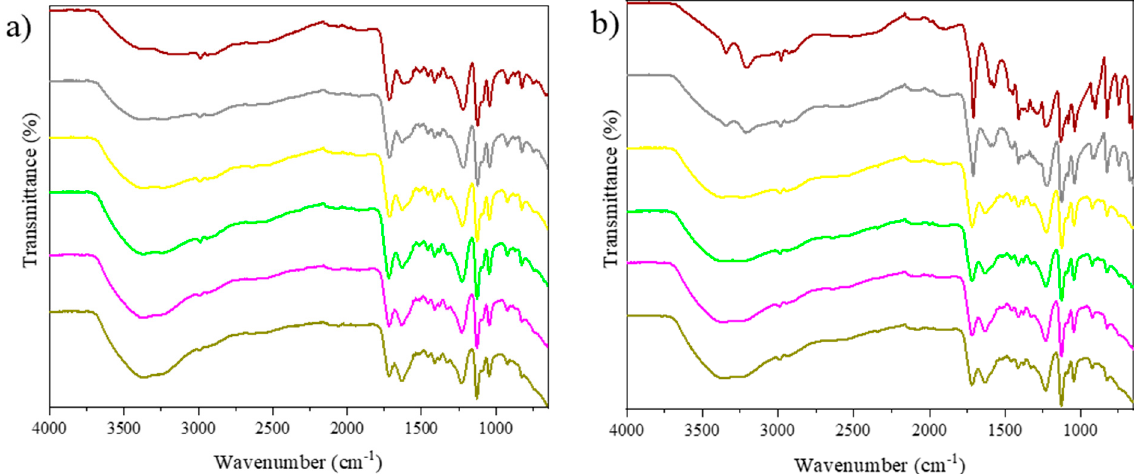
Figure 5. Spectra (FTIR) of lactic acid:glycine mixtures with different proportions of water. ( a ) One day after NADES preparation — (brown line) (5%); — (gris line) (10%); — (yellow line) (20%); — (green line) (30%); — (pink line) (40%); — (moss green line) (50%). ( b ) Eight months after NADES preparation — (brown line) (5%); — (gris line) (10%); — (yellow line) (20%); — (green line) (30%); — (pink line) (40%); — (moss green line) (50%).